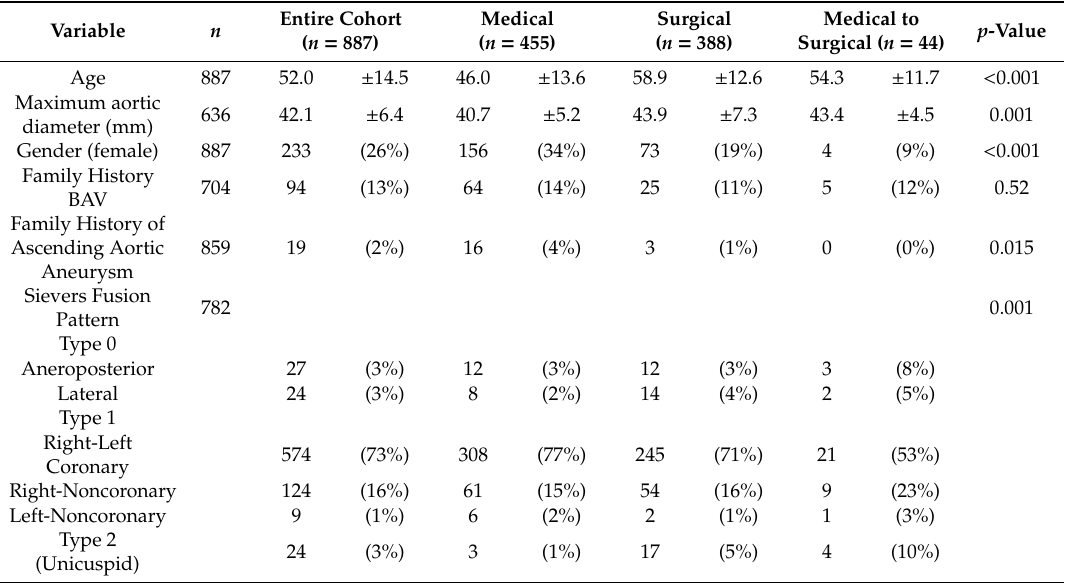
Baseline characteristics of patients presenting to bicuspid aortic valve (BAV) clinic, by clinical